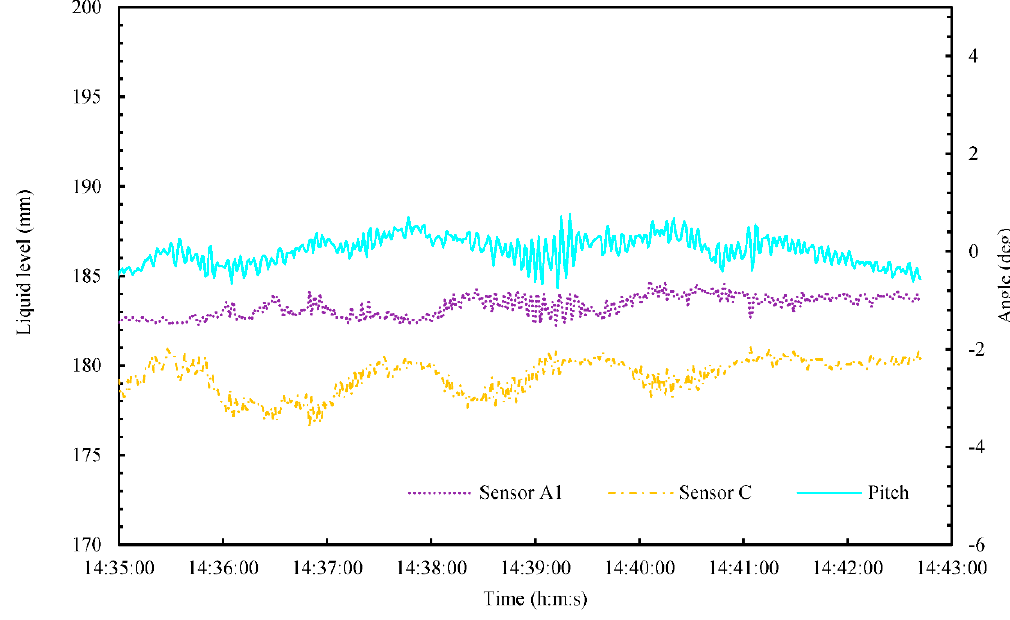
Figure 13. Time series of the liquid level and pitching angle during a zigzag maneuver from 14:35 to 14:42.